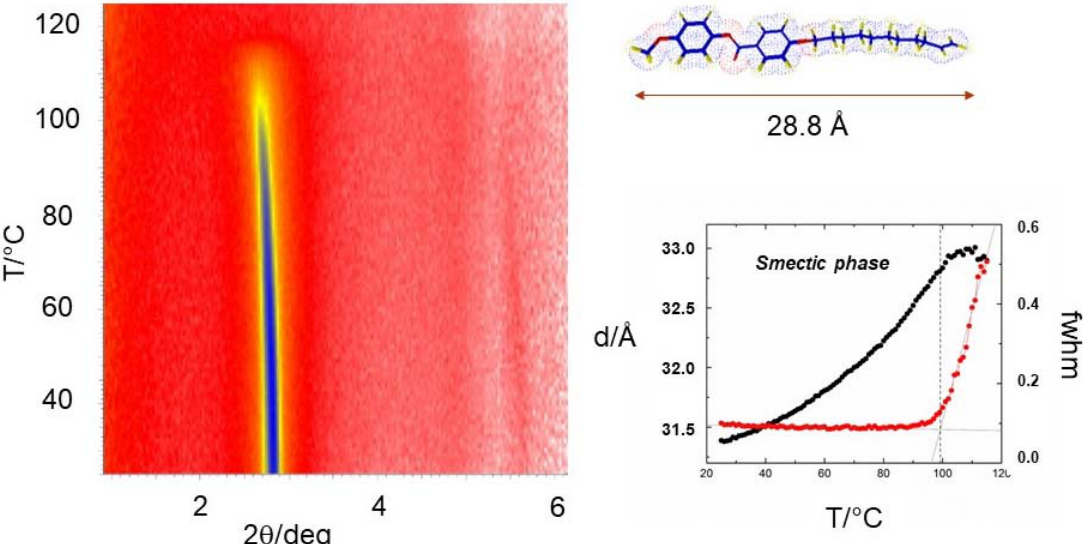
Figure 6. Temperature evolution of small-angle XRD pattern for the monodomain SC-LCE 2 sample. Diffracted intensity is coded with color (red to yellow to blue). On the right-top side, the optimized molecular structure of M11 (smectogen) showing its average length. On the right-bottom, layer spacing (d—black points) and diffraction signal width at its half-maximum (fwhm—red points) are reported as a function of temperature.